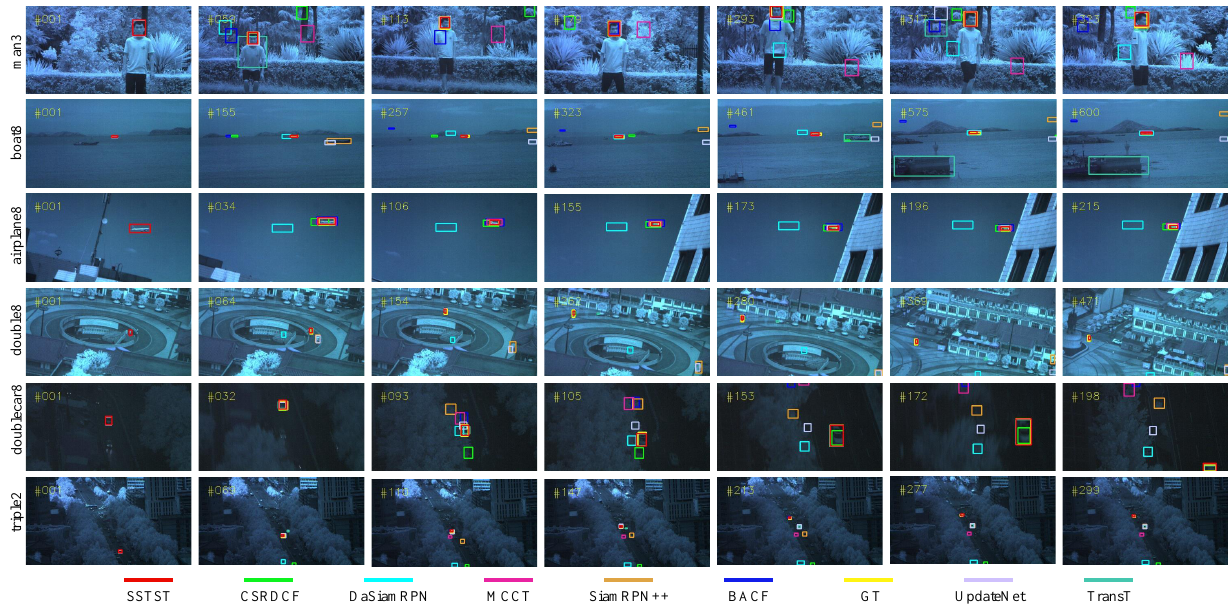
Figure 10. Qualitative results of the proposed method on some challenging sequences on IMEC25.